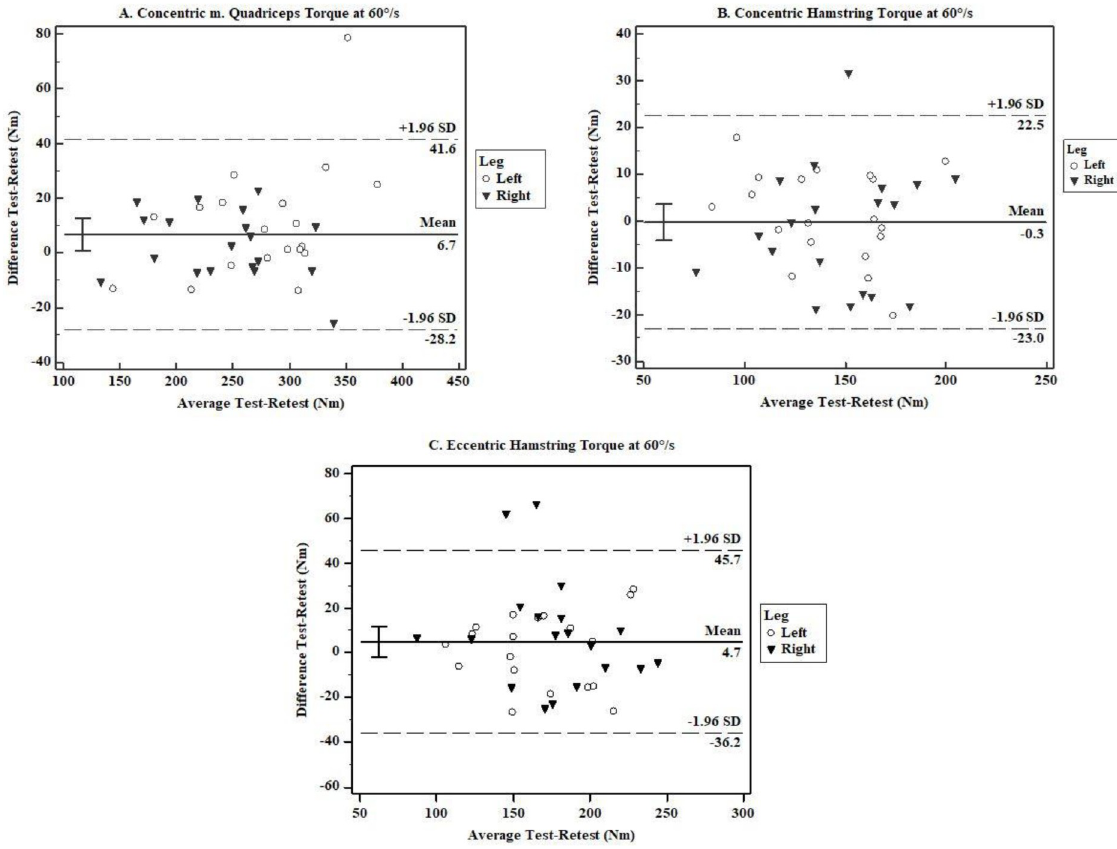
Fig 2. Test-retest qualitative agreement of concentric torque of Quadriceps (a.) and Hamstrings (b.), and eccentric torque of Hamstrings (c.).